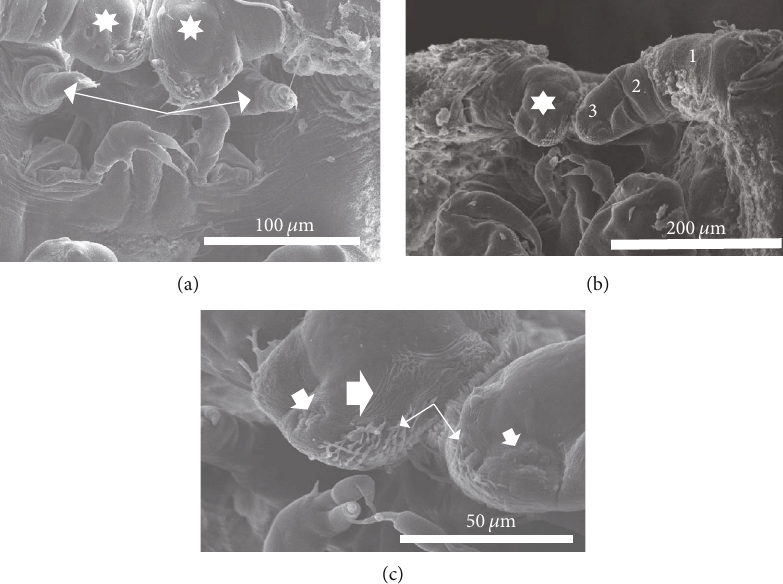
Figure 4: (a) Overall view of antenna positioning. Note primary antennae (arrows) and secondary antennae (asterisks). (b) Basic structure of secondary antennae showing 3 segment pattern. Asterisk indicates terminal segment of antennae. (c) Detail of the terminal segment of second antenna. Note microridges (large arrowhead), fl exible spines (thin arrows), and sensory pits (small